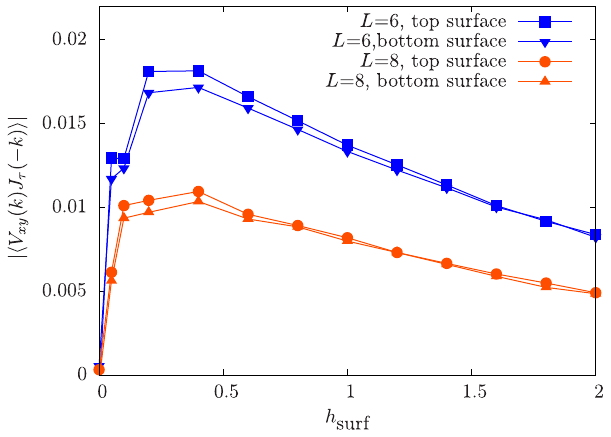
FIG. 6. Spin vortex-boson charge correlators near the surface of the binding phase in the model Eqs. (1) and (2) using Heisenberg spins. The horizontal axis is the strength of the Zeeman field applied only near the surfaces (and of opposite sign on the two surfaces). We see that as soon as the Zeeman field is turned on, the correlator takes a nonzero value. The value is nonuniversal, but it is approximately the same on the top and bottom surfaces. Data are taken with β ¼ 0 , λ ¼ 5 . 2 everywhere and the binding phase occupying half of the system, cf. Eq. (17). Since we do not know how to properly couple external gauge fields to this system, we are unable to compute the Hall